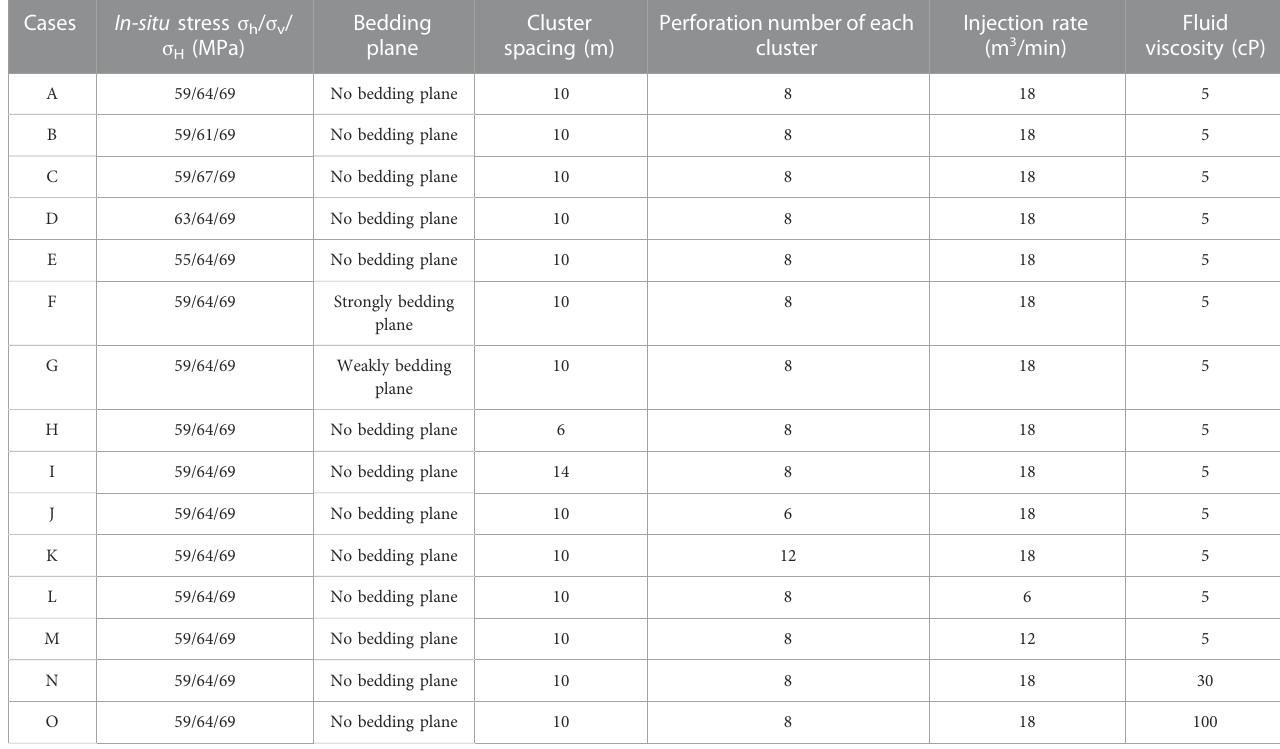
TABLE 2 Summary of the input parameters of each modeling case.